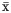
Annexin V/PI-staining of TTC-reactive REH cells and control cells treated with TTC fusion proteins and equivalent control proteins.The assay was carried out after incubating the TTC-reactive REH cells (A) or control REH cells (B) with 50 nM of each protein for 72 h at 37°C. The induction of apoptosis was measured by FACS after annexin V/PI staining. Representative dot blots are shown with the cells distributed as follows: lower left = viable cells, lower right = early apoptotic cells, upper right = late apoptotic cells. (C)The Induction of apoptosis following treatment with TTC-ETA' and GrB(R201K)-TTC. TTC-reactive REH cells (left) and the control REH cells (right) were incubated with 50 nM TTC-ETA', Mock-ETA', GrB(R201K)-TTC or GrB(R201K)-Mock, with a buffer-only negative control and a camptothecin positive control for 72 h at 37°C. The sum of early and late apoptotic cells (x¯ ± SD) from three independent experiments carried out in duplicate is presented for each protein. The statistical significance was determined by one-way ANOVA followed by Bonferroni’s post-hoc test (***: p ≤ 0.001, **: p ≤ 0.01).